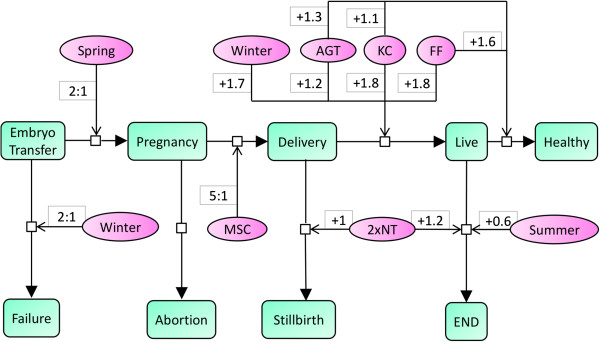
The major statistical effects of the investigated factors on the outcome stage of the recipients (pregnancy/delivery) and the offspring (live/healthy). For each impact, the gain during a certain transition is given in the respective outcome unit. For example, there are on average 1.7 more alive piglets for cloning in winter, as compared to the reference (cloning in spring). MSC: mesenchymal stem cells, AGT: additive gene transfer, KC: kidney cells, FF: fetal fibroblasts, NT: nuclear transfer, END: early neonatal death.